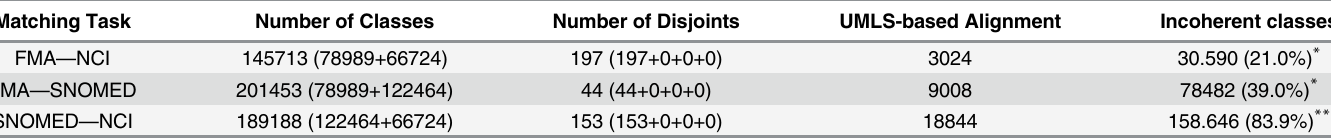
Table 1. Total number of classes and disjointness axioms of the matched ontologies, the size of the of the original (unrepaired) UMLS-based align- ment, and the number of incoherent classes for each OAEI large biomedical track matching problems. The number of syntactic, cardinality, functional and Object based disjointness axioms relative to the each matching task are shown in parentheses. Matching